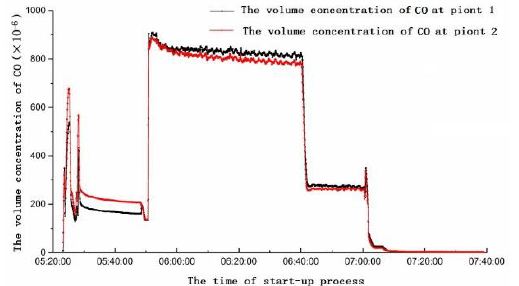
Figure 17. CO concentration at Point 1 and Point 2.